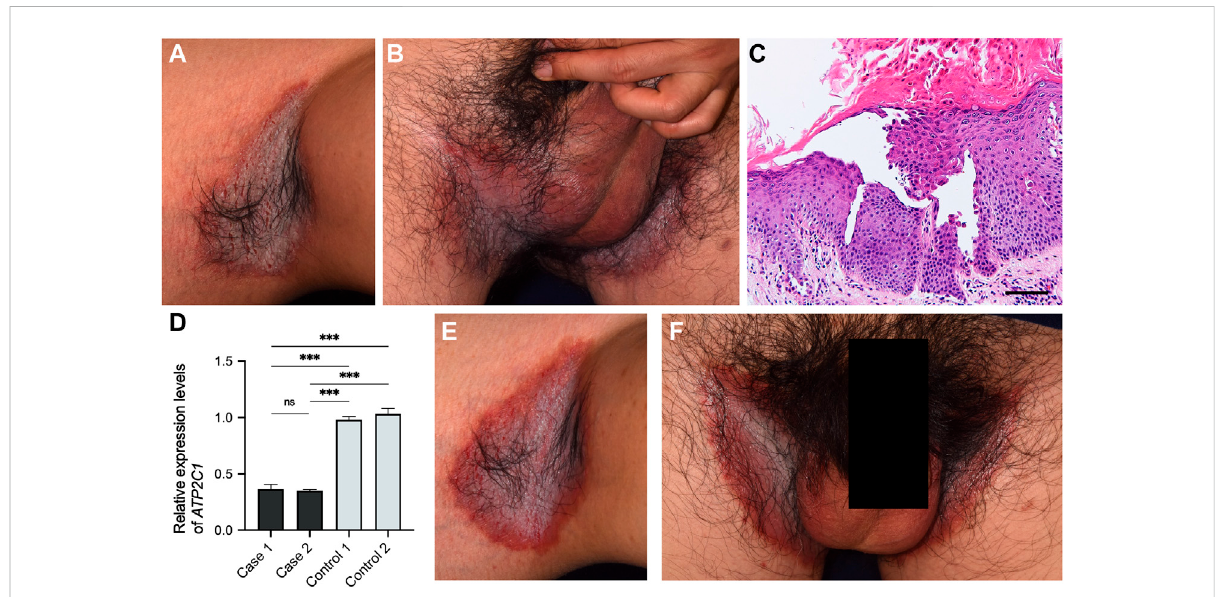
FIGURE 2 Clinical and histological features of Case 2. (A, B) Clinical fi ndings at the fi rst visit to our hospital. (C) Pathological features of the lesion on the rightaxilla.Hematoxylinandeosinstaining(scalebars,100 μ m). (D) Geneexpressionlevelsof ATP2C1 inwholeskinsamplestakenfromHHDpatients and healthy controls. Statistical signi fi cance was calculated using one-way ANOVA with multiple comparisons test. Error bars represent SD. *** p < 0.001; ns, not signi fi cant. (E, F) No improvement after three months of treatment with